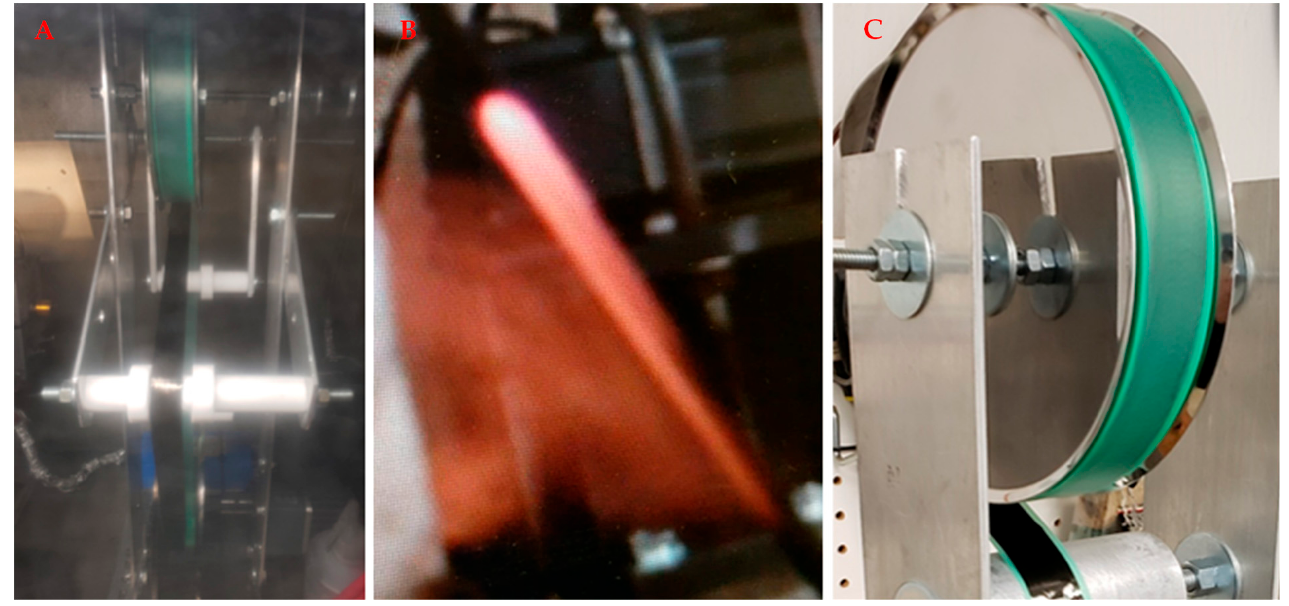
Figure 4. Tape coating and layering machine used for wrapping of CF tape onto CNT. ( A ) CNT can be coated onto the tape. ( B ) The red is the reflection of the light caused due to hot sock at the outlet from the reaction process. ( C ) The CNT web or sock exits the reactor tube and is deposited onto the CF tape and wound from one spool to another in the tape-laying machine.